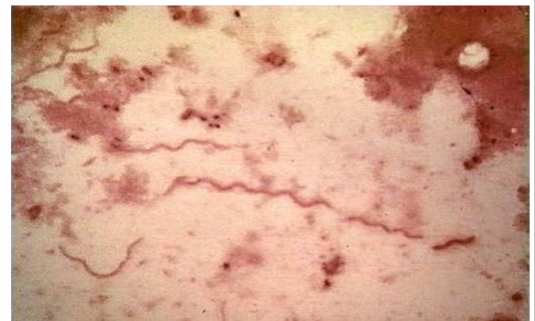
Figure 3. Optical microscope image of Borrelia sp. from Ixodes ricinus bowel, stained with Congo Red (photo by M. Cinco).